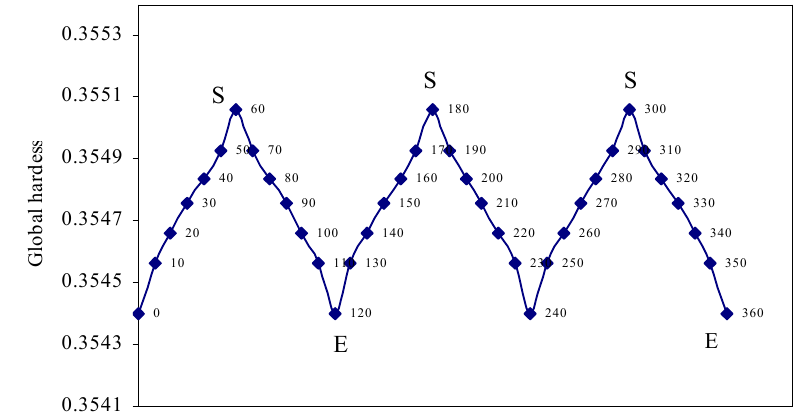
Figure 5. Plot of Global hardness of F (E-Eclipsed, S-Staggered)